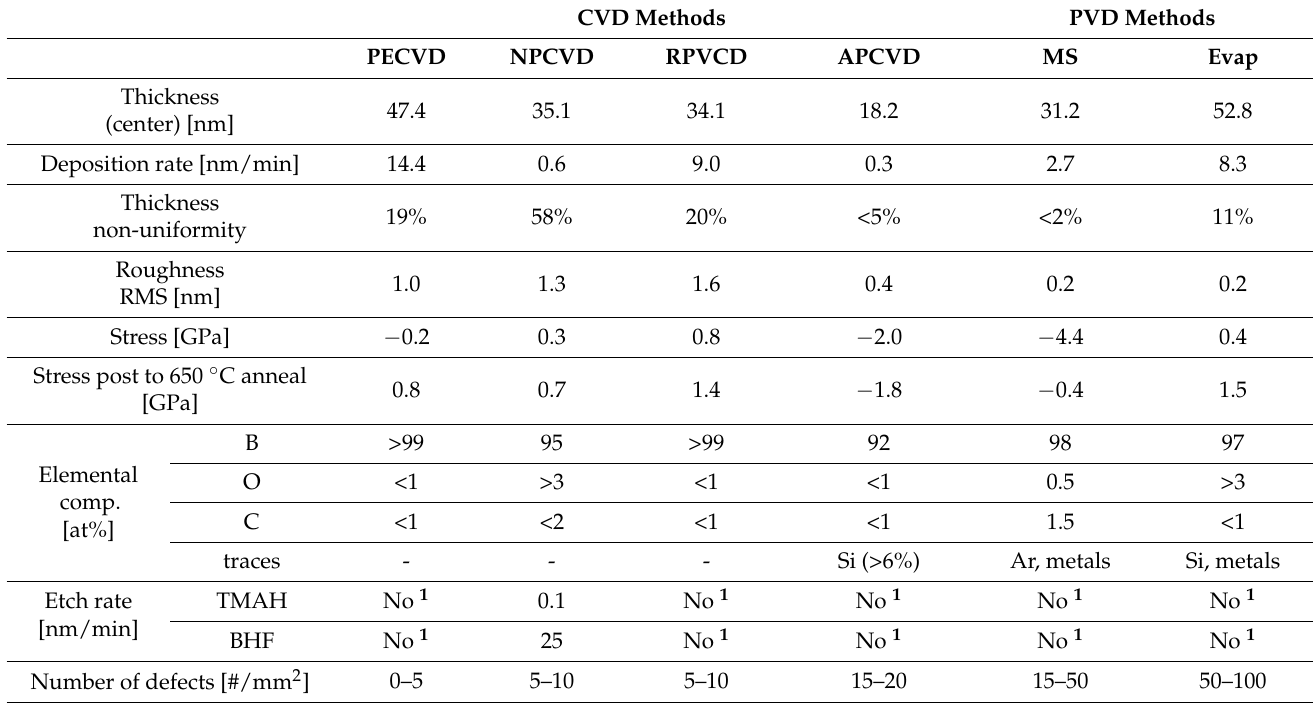
Table 2. Characteristics of boron thin films realized in this work by various CVD and PVD methods, i.e., plasma enhanced CVD (PECVD), non-plasma CVD (NPCVD), remote plasma CVD (RPCVD), atmospheric pressure CVD (APCVD), magnetron sputtering (MS) and electron-beam evaporation (Evap). Shown data are obtained from the center of the wafer. The thickness non-uniformity is calculated as percentage from the boron thickness measured at the center of the substrate relative to the thickness at 40 mm from the center. The XPS atomic percentages indicate those at half-thickness of the layer ( 1 : ‘No’ implies no loss in material